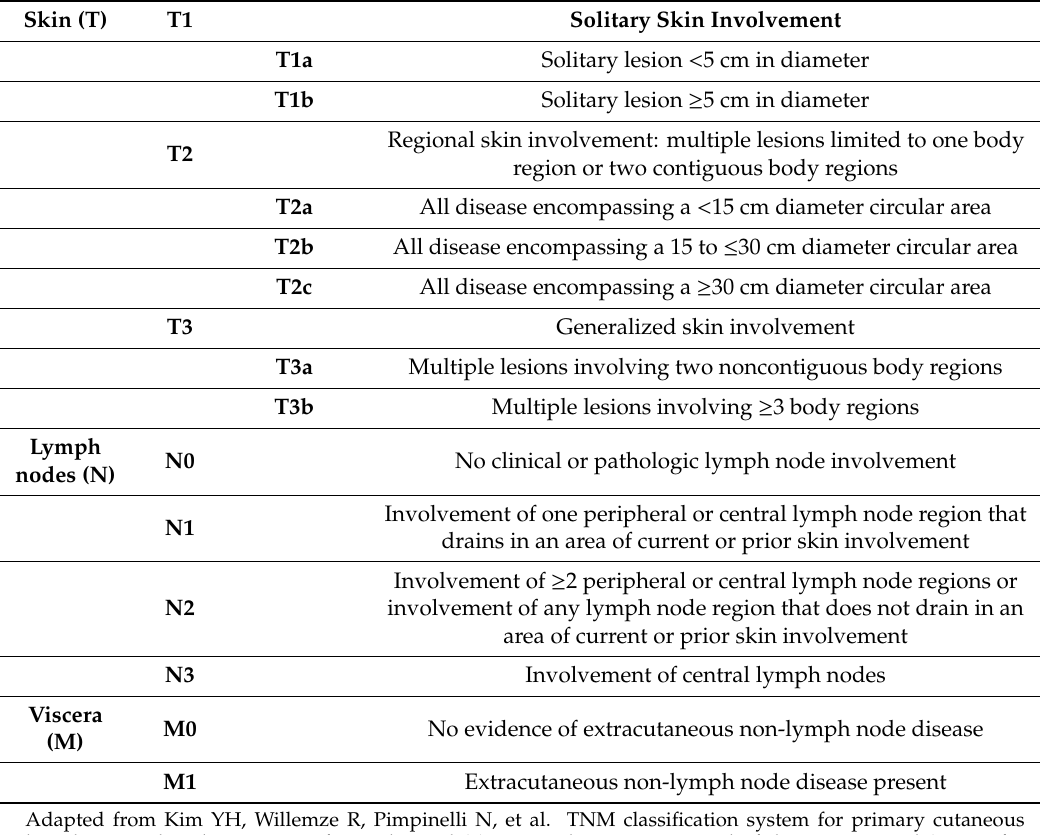
Table1. InternationalSocietyforCutaneousLymphomas(ISCL) / EuropeanOrganizationofResearchand Treatment of Cancer (EORTC) tumor, node, metastases (TNM) classification of cutaneous lymphomas other than mycosis fungoides (MF) / S é zary syndrome